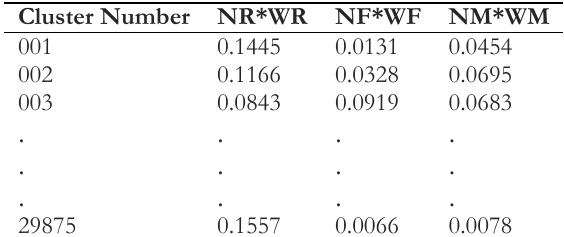
Table 5. Data weighted